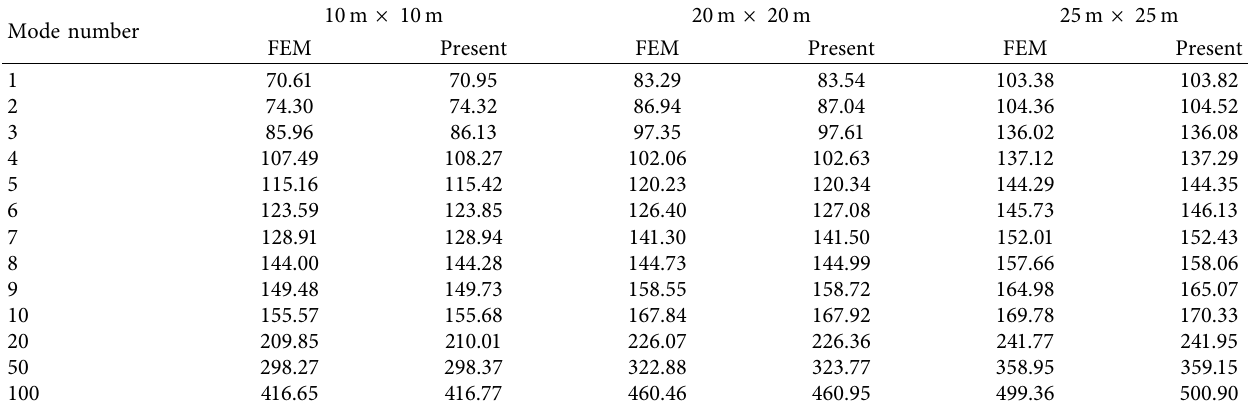
Figure 5: The first six mode shapes for the square plate with eight cutouts. (a) The first mode; (b) the second mode; (c) the third mode; (d) the fourth mode; (e) the fifth mode; (f) the sixth mode. Upper: the present results; lower: the ANSYS results. Table 3: The natural frequencies of the rectangular plate with different cutout